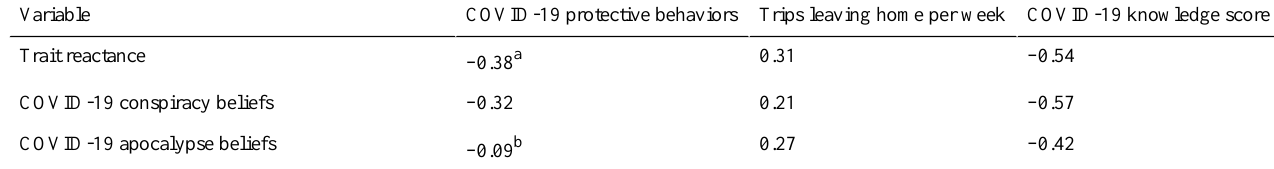
COVID-19 knowledge scoreTrips leaving home per weekCOVID-19 protective